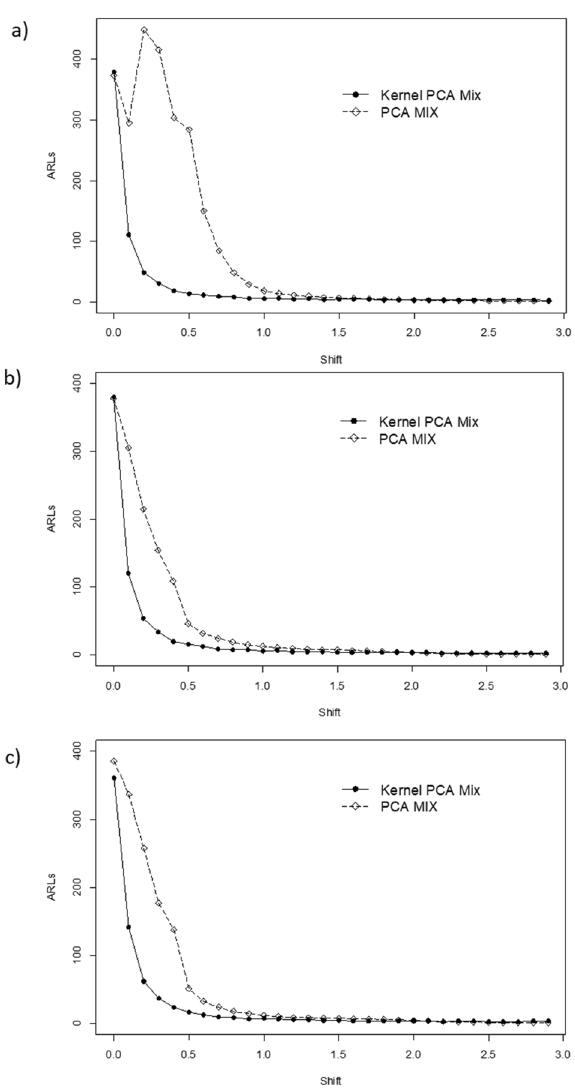
Figure 4. ARLs comparison between Kernel PCA Mix and PCA Mix charts with an imbalanced parameter of attribute characteristic for: ( a ) l = 2, ( b ) l = 3, and ( c ) l =